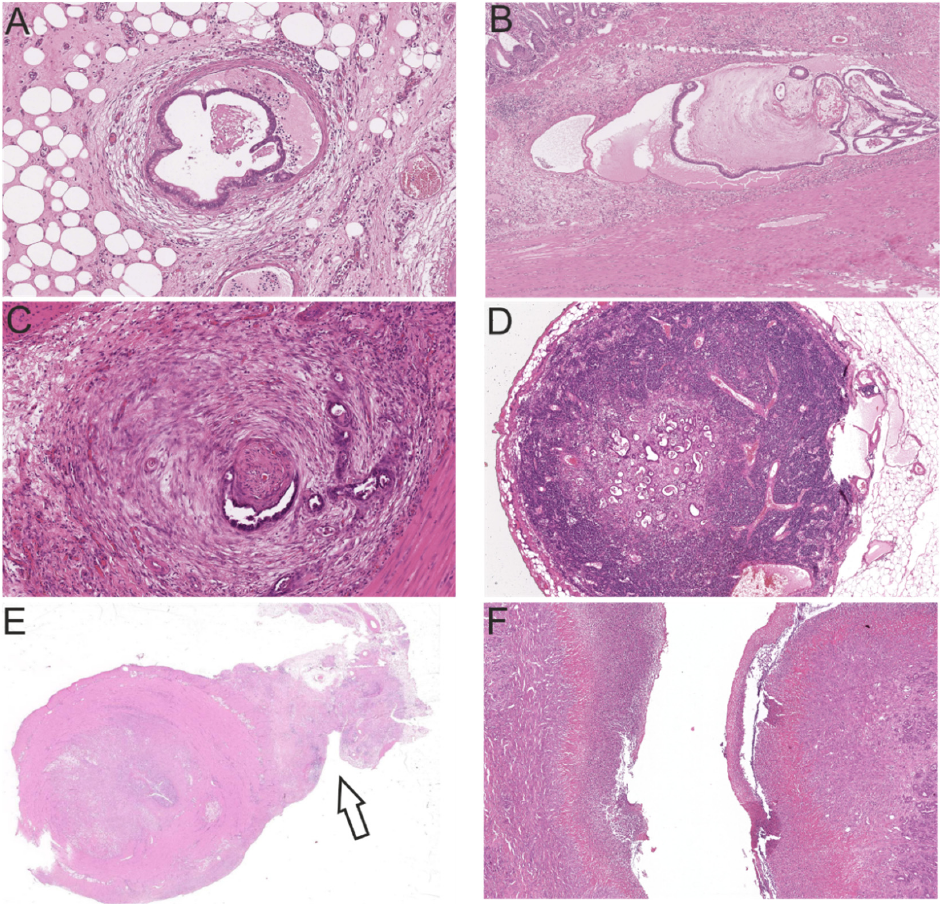
Figure 4. Characteristic malignancy features of feline intestinal tumors (H&E). ( A ) Vascular invasion (10×); ( B ) Lymphangiosis carcinomatosa (4×); ( C ) Perineural invasion (10×); ( D ) Lymph node metastasis (4×); ( E ) Serosal invasion, arrow (1×); and ( F ) Mucosal ulceration (4×).